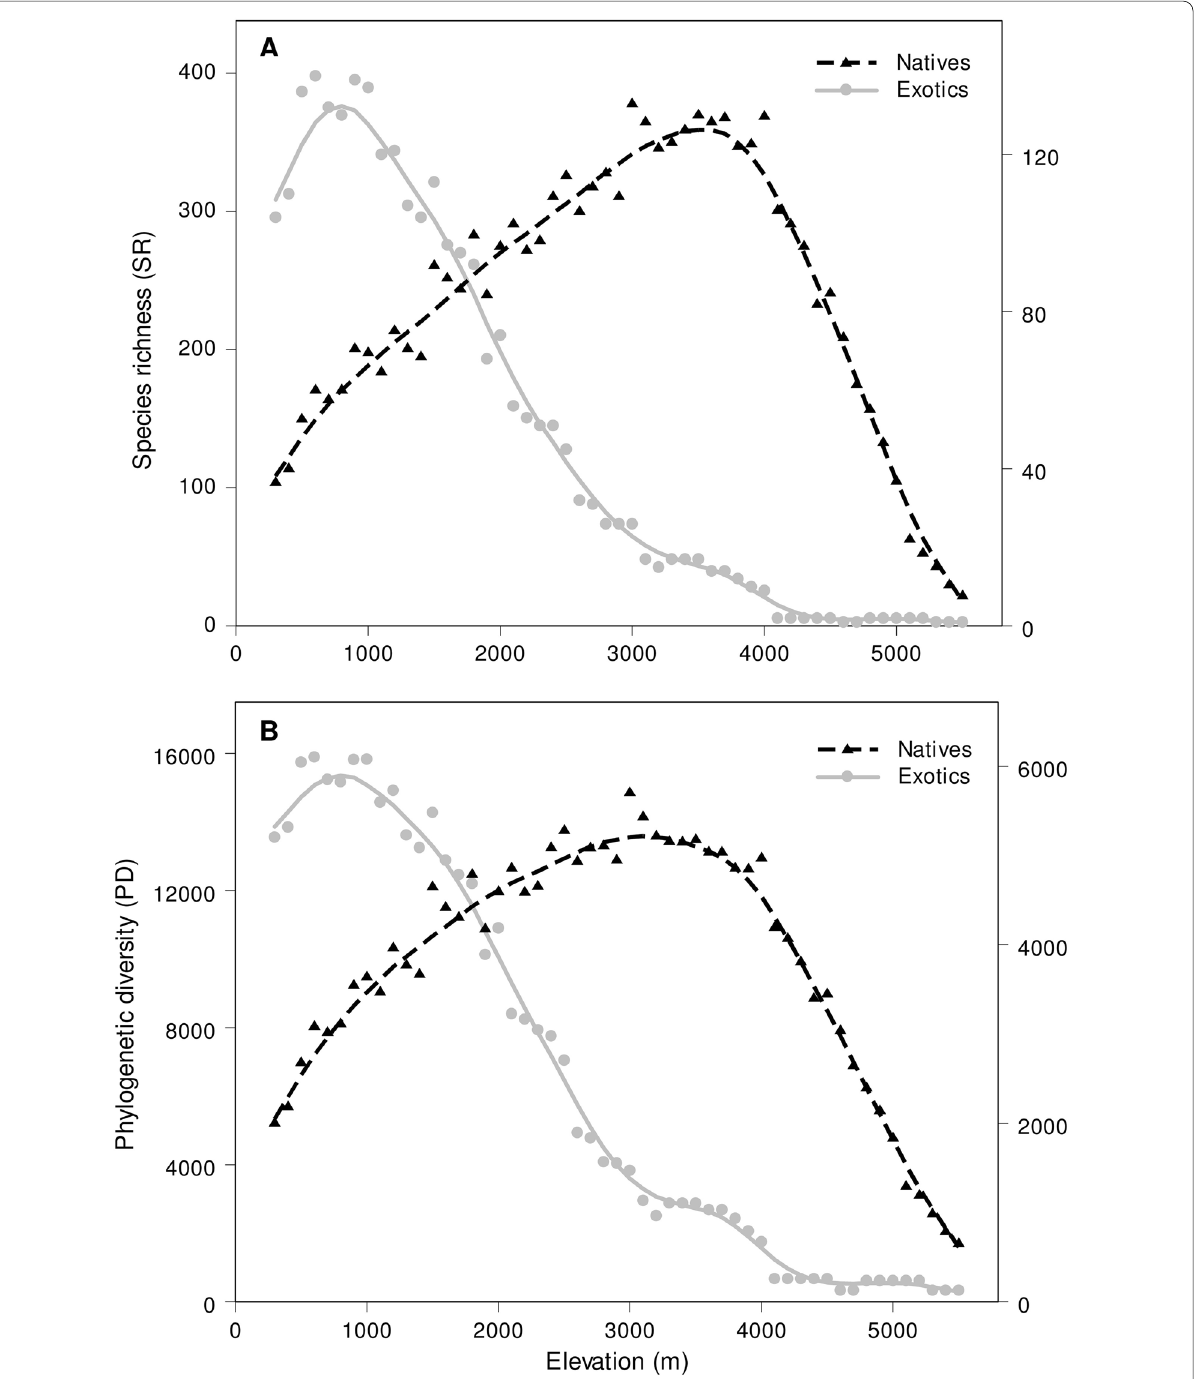
Fig. 2 Variation of ( A ) Species richness (SR) and ( B ) Phylogenetic diversity (PD) of exotic and native plant species along the elevational gradient in Sikkim Himalaya. Both exotic and native plant species showed unimodal hump-shaped curves for PD and SR along the elevational gradient. The primary Y -axis in both the plots represents SR and PD of native species, while secondary Y -axis represents SR and PD of exotic species. The fitted lines in both the plots were generated using Friedman’s super smoother function and do not imply any cause–effect